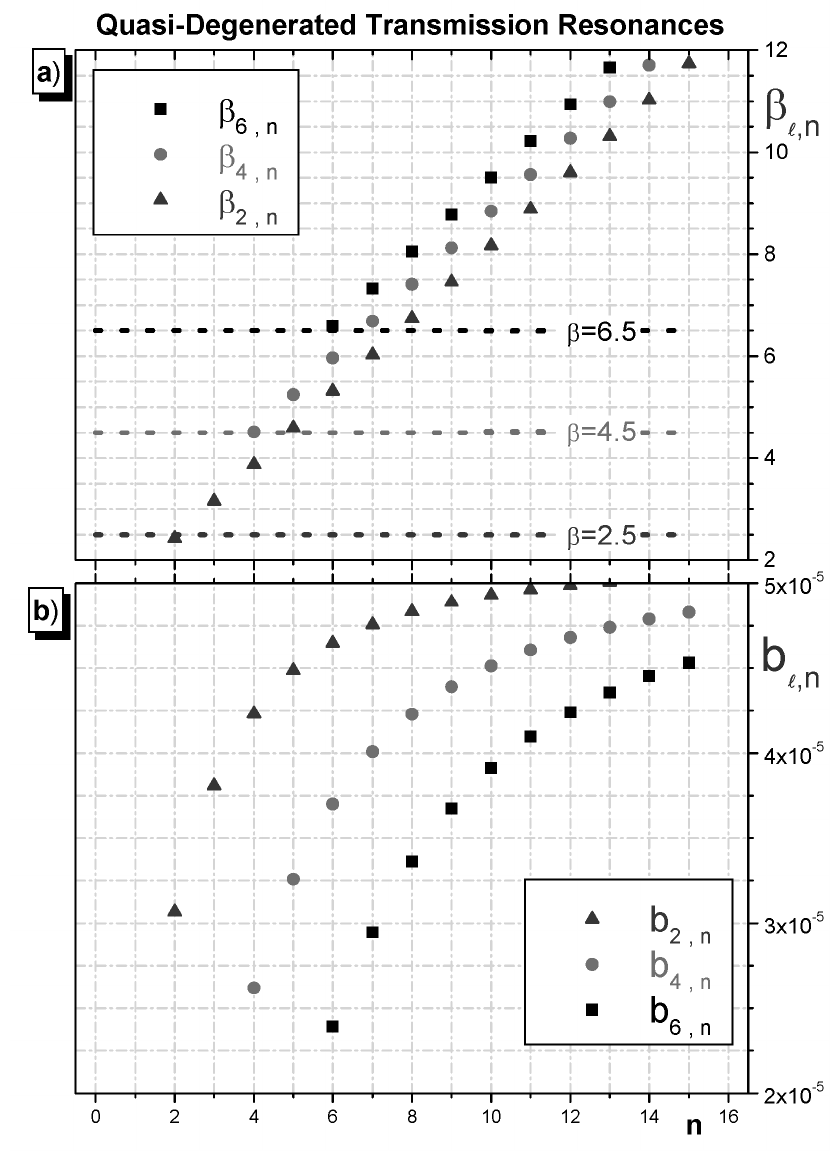
Figure 9 - For even multipoles (cid:96) = 2 , 4 , 6 , this figure shows for Quasi-Degenerated Trans- mission Resonances the behavior of the positions (top panel– a ) and widths (bottom panel– b ) as the resonance order n